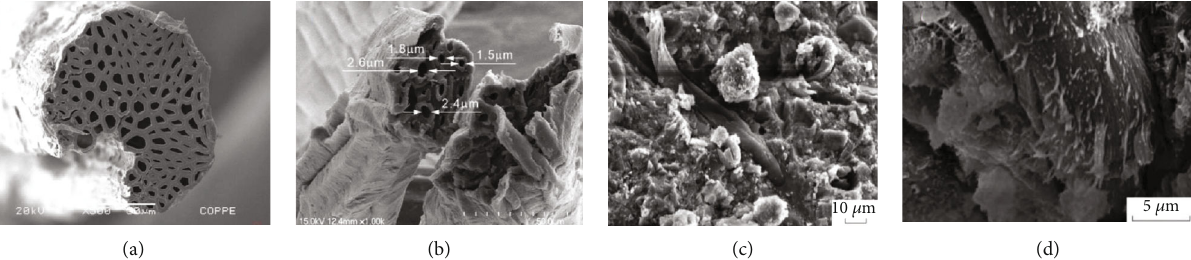
Figure 1: SEM images of CFs. (a) Sisal fi bers [39]. (b) Jute fi bers [13]. (c, d) Combination of the macroscale fi ber and cement matrix